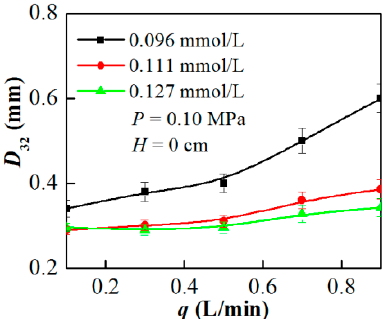
Figure 11. D 32 as a function of suction capacity ( q ).